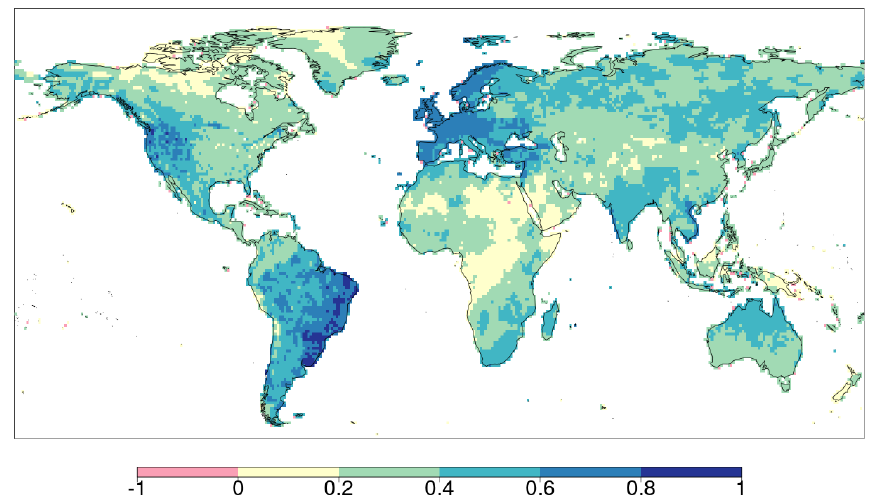
Figure A1. Temporal correlations between REGEN and CPC, similar to Fig. 12d, but this time with CPC shifted a day backwards.